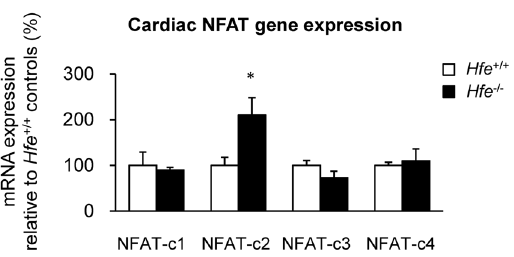
Figure 4. NFAT expression in Hfe + / + and Hfe − / − mice. The expression levels of the NFAT genes in the heart from Hfe + / + and Hfe − / − mice (n = 5 per group) at 12-months of age were quantified by real-time qPCR. Data are presented as the means ± SEM. * p < 0.05 between Hfe − / − and Hfe + / + mice assessed by the two-sample t